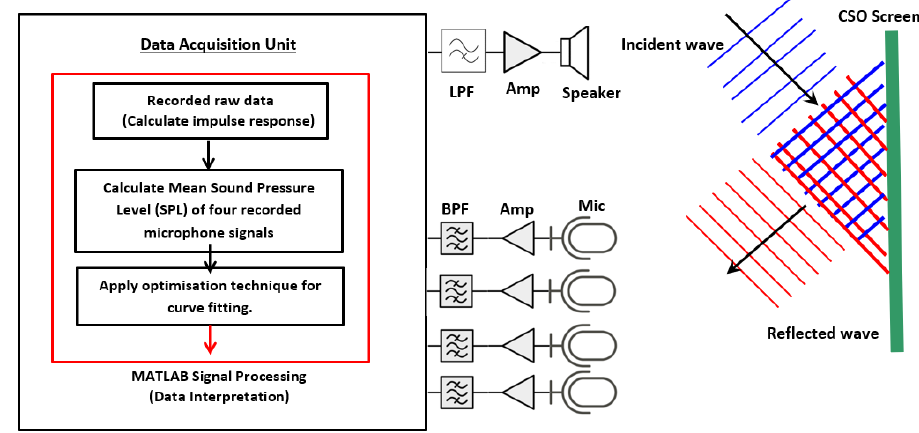
Figure 2. Basic operation block diagram of the system.